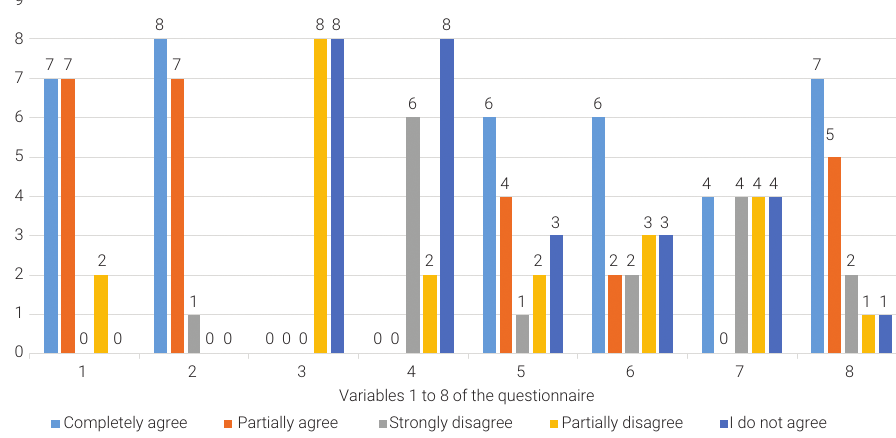
Figure 2. Number of adolescents of G1 who answered the 8 variables of the questionnaire (1 to 8) according to the Likert